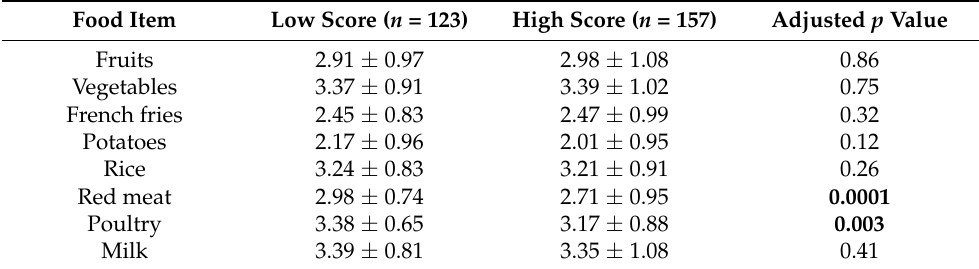
Table 4. Participant intake of selected food items according to their concern over climate change